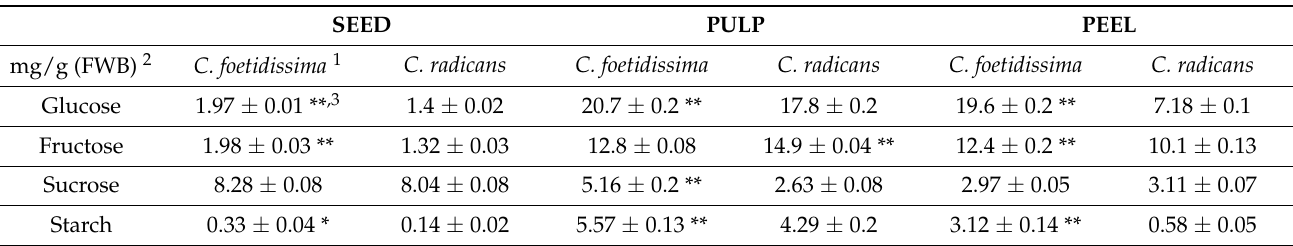
Table 5. Soluble and insoluble non-structural carbohydrate (NSCs) levels in Cucurbita foetidissima and C. radicans fruits. NSC content was determined in fruits collected from C. foetidissima and C. radicans plants collected in the wild from sites localized in the state of Jalisco, Mexico.